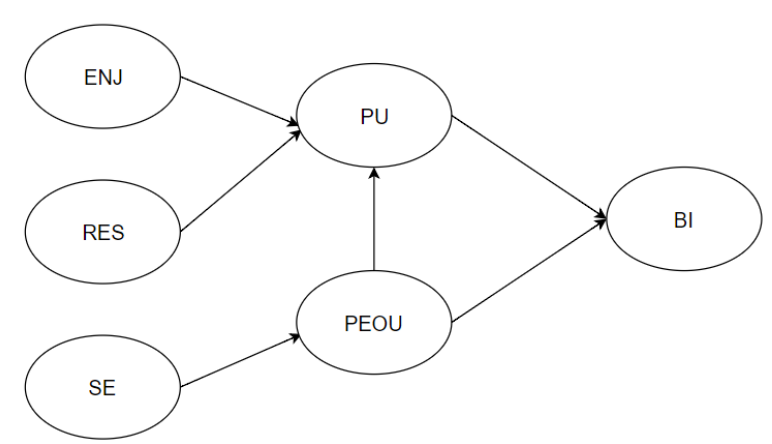
Fig. 1. Proposed Research